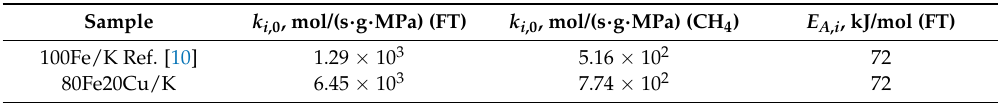
Table 6. Comparison on kinetic parameters of 100Fe/K and